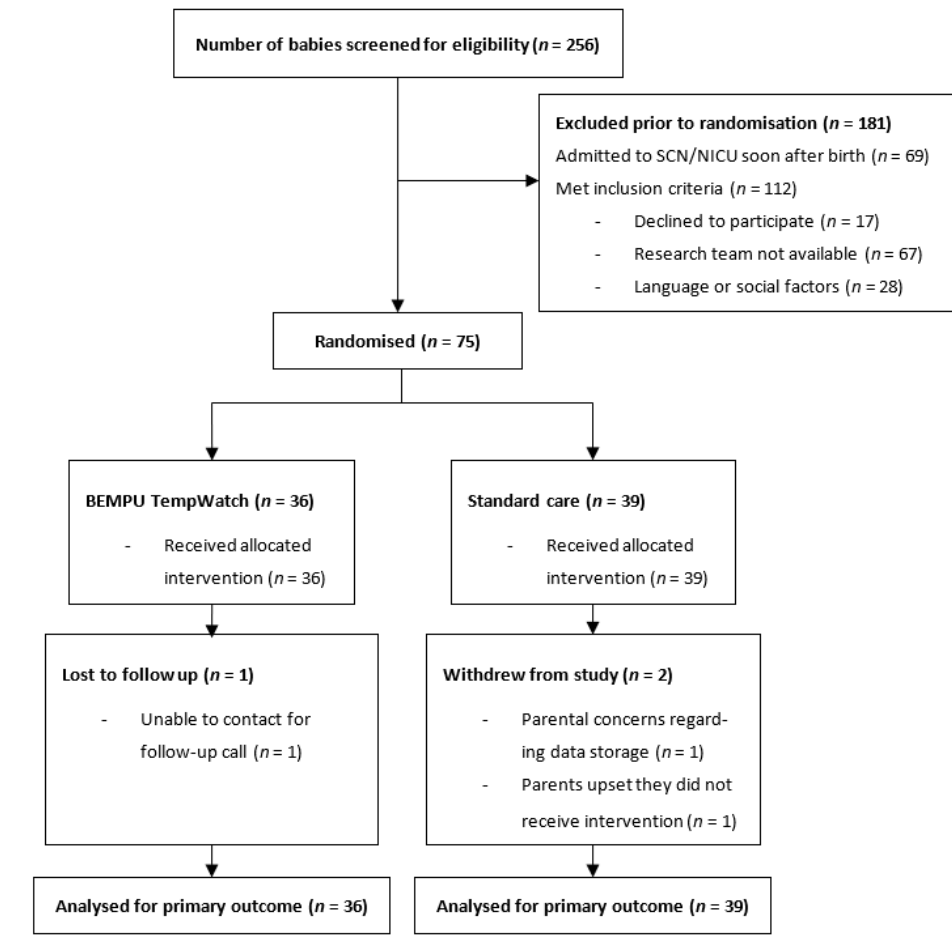
Figure 2. CONSORT diagram. CONSORT, Consolidated Standards of Reporting Trials. Table 1. Demographic characteristics of mothers and neonates.